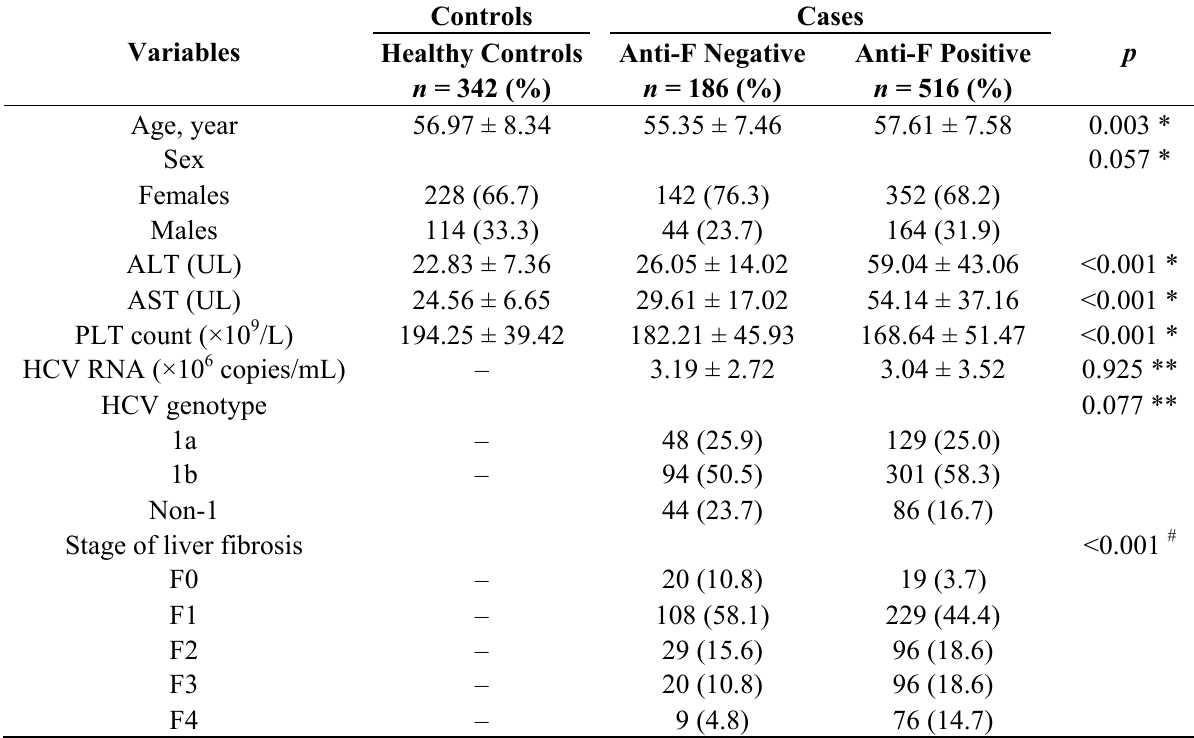
Table 1. Distributions of selected variables in HCV-infection patients and healthy controls.